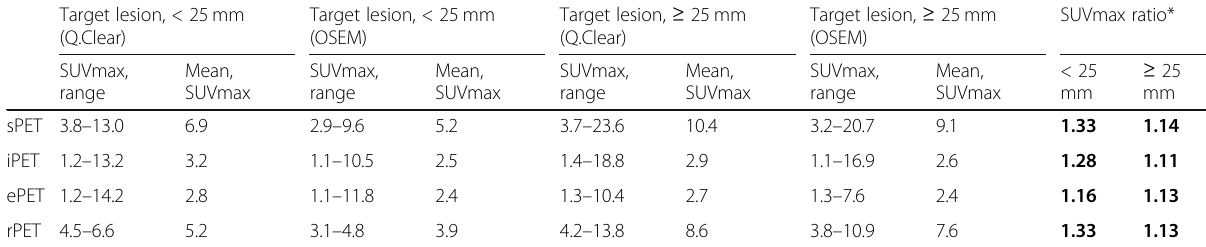
Table 4 SUVmax values measured in smaller (< 25 mm) and larger ( ≥ 25 mm) target lesions using both reconstruction algorithms Target lesion, < 25 mm